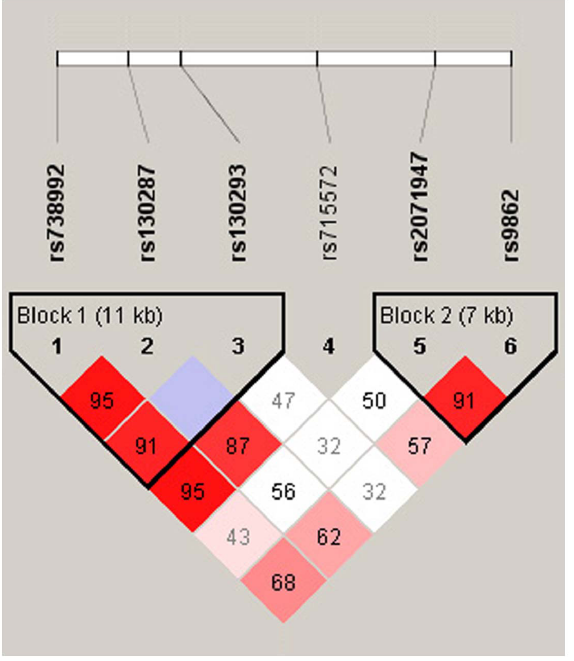
Figure 1. Linkage disequilibrium (LD) plot of six SNPs of the TIMP3 gene. LD plots were prepared from both subject groups; D’ values that correspond to SNP pairs are expressed as percentages and are shown within the respective squares. Higher D’ values are indicated with a brighter red color. These six SNPs constitute two haplotype blocks that span 11 kb and 7 kb of the TIMP3